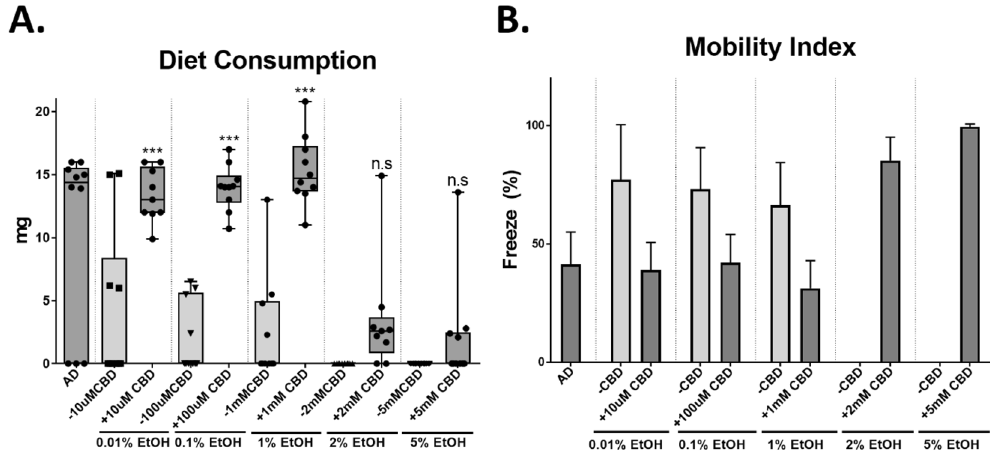
Figure 3. The effects of CBD on insect behaviors. ( A ) Diet consumption of insects reared on AD, AD + 0.01– 5% EtOH, and AD + 0.01% EtOH + 10 μ M-5mMCBD (one-way ANOVA, Tukey’s multiple comparison at p < 0.05). ( B ) Insect mobility. The mobility is depicted as freeze